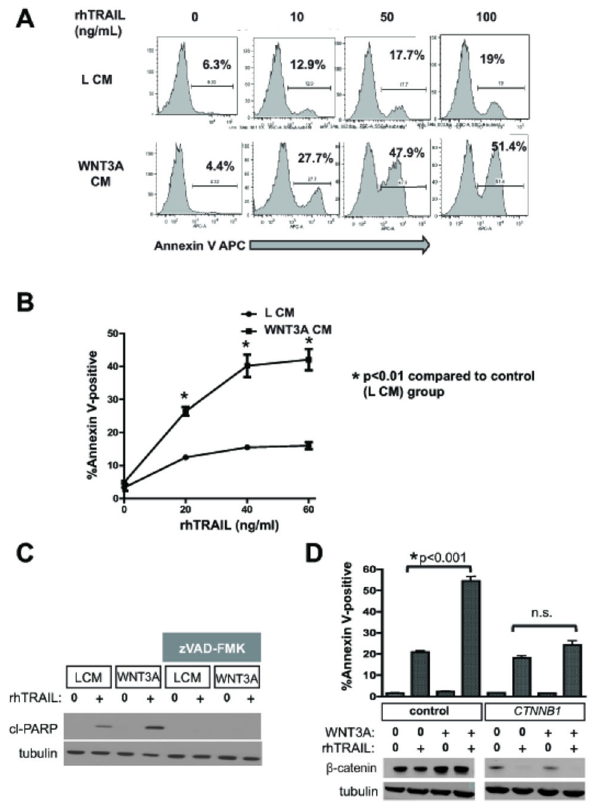
Figure 1. WNT3A sensitizes melanoma cell lines to TRAIL in a β-catenin-dependent manner. A) A375 melanoma cells were treated with indicated doses of rhTRAIL for 24 hours in the presence of WNT3A or control L-cell (L) CM (10%).